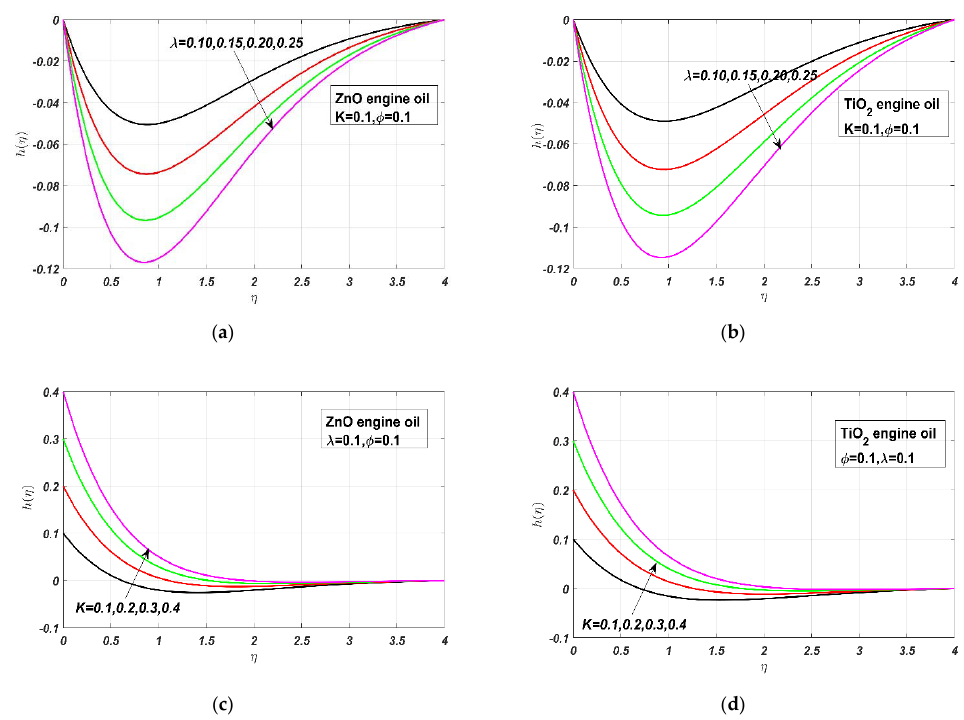
Figure 3. The impact of rotation parameter (cid:2019) ( a , b ) and slip parameter (cid:1837) ( c , d ) on the velocity profile ℎ((cid:2015)) for ZnO and TiO (cid:2870) engine oil nanofluids.